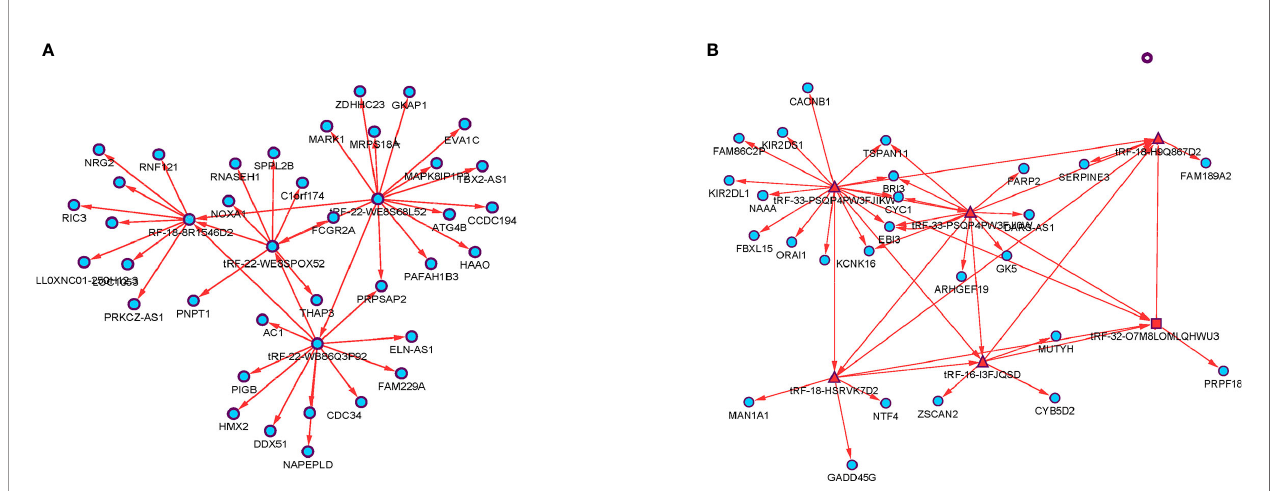
FIGURE 4 | The tsRNA/mRNA network analysis. (A) Four diagnostic model selected tsRNAs and their predicted target mRNAs. (B) Seven prognostic model selected tsRNAs and their predicted target